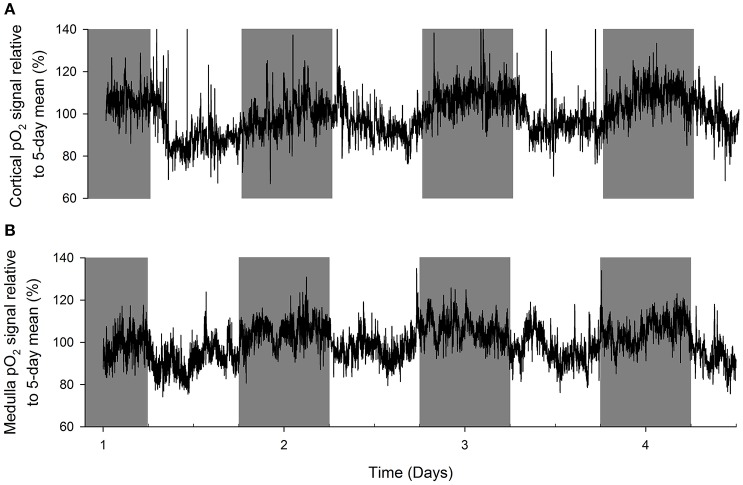
Representative examples of original recordings (A) in a rat with an oxygen sensor placed in the cortex of the kidney and (B) in another rat with the probe in the renal medulla. Data are 10 second averages during consecutive days. Note that in both cortex and medulla, tissue oxygenation peaks during the lights-off (active) period of the day (marked in gray). Troughs in tissue pO2 are visible in the lights-on (resting) period.